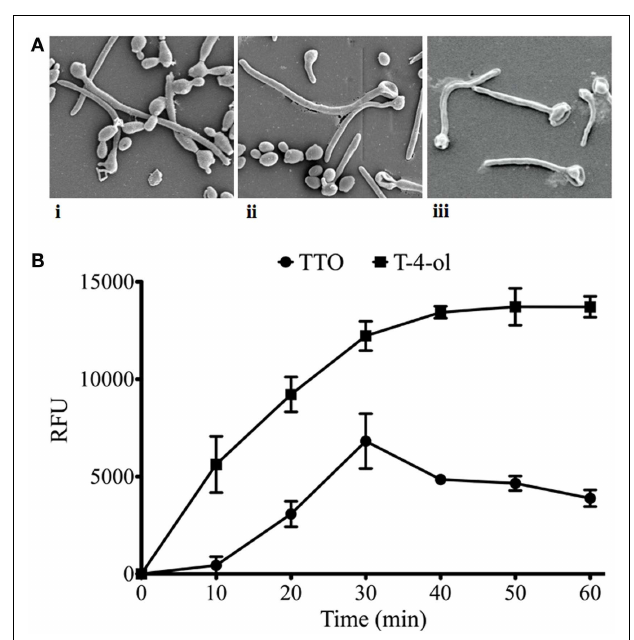
FIGURE 3 |Tea tree oil andT-4-ol are cell membrane active. (A) Adherent cells (3153A) were adhered for 2h onThermanox™coverslips and were (i) untreated (control), or treated with (ii) TTO, or (iii) T-4-ol at 2 × MIC 50 for 24h.These were then processed and viewed on an SEM. (B) C. albicans (3153A) planktonic cells (5 × 10 7 cells/ml) were treated withTTO,T-4-ol, or α -terpineol at a concentration of 2 × MIC 50 for 10, 20, 30, 40, 50, and 60min. The cells were washed by centrifugation, resuspended in PI (20 µ M in PBS), and incubated for 15min at 37˚C.These were then transferred to a black 96-well plate for quantification in a fluorescent plate reader (Ex 485 /Em 620 ). Each assay was performed on at least two independent occasions in triplicate. Error bars represent the ± standard error of the